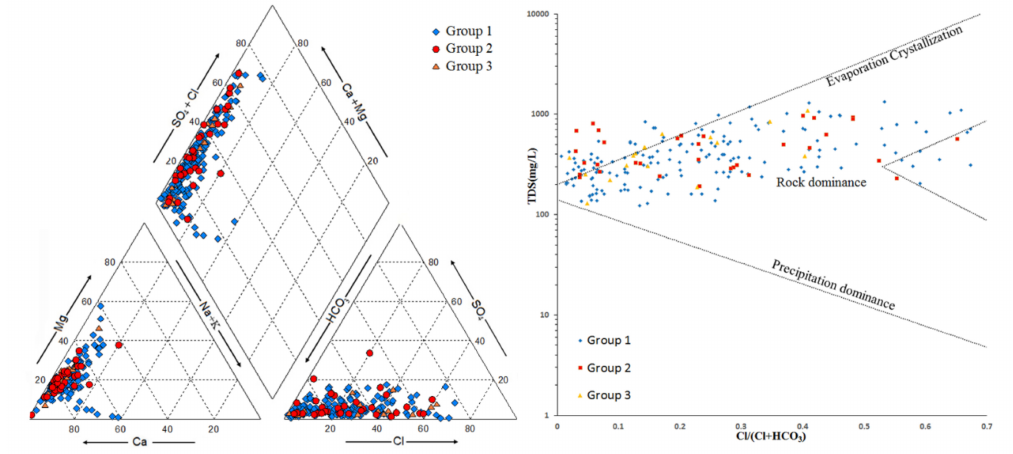
Figure 5. Piper three-line diagram and Gibbs diagram in the study area.